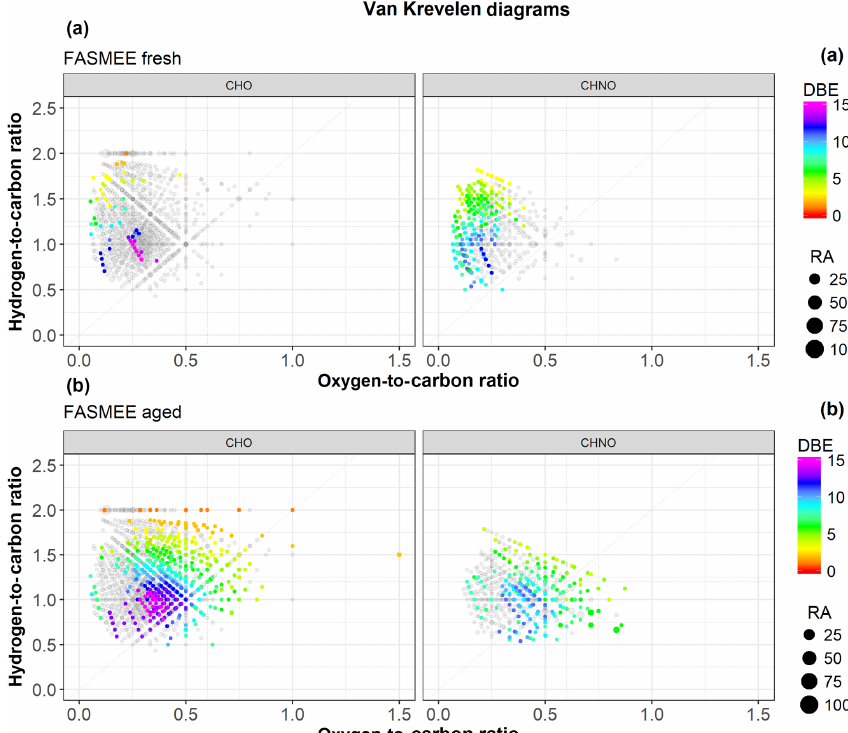
Figure 10. Van Krevelen plots of H : C and O : C ratios for the negative ion ultrahigh-resolution mass spectra of fresh (a) and aged (b) FAS- MEE water-soluble aerosol. CHO and CHNO molecular formulas are shown separately. Grey circles indicate common molecular formulas observed in both the fresh and aged samples; colored circles indicate the unique molecular formulas for the fresh or aged water-soluble aerosol. The color represents the number of DBEs and the size of the circles indicates the normalized relative abundance of the peaks in the mass